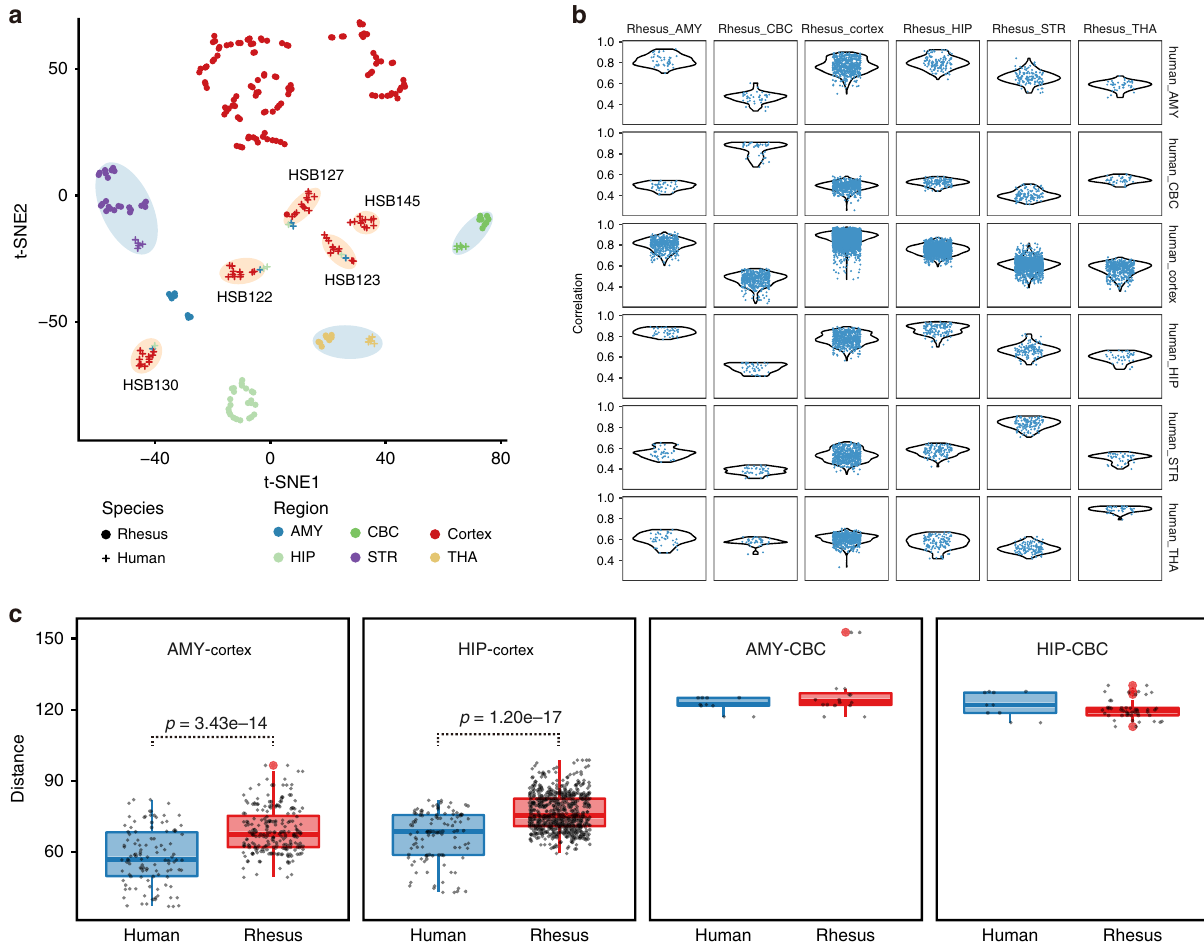
Fig. 2 Similar expression pro fi les between human and macaque brains. a Combined t-SNE using the human and rhesus macaque dataset. The blue shadow circles indicated similar expression pattern in the striatum, thalamus and cerebellar cortex between human and rhesus macaque. The orange shadow circles indicated clusters of samples from the same individual. b Violin plot showing the distribution of correlation coef fi cient of homologous genes in same structure between human and rhesus macaque. c Boxplot showing the euclidean distance between amygdala (AMY) and cortex, hippocampus (HIP) and cortex, AMY and cerebellar cortex (CBC), HIP and CBC in the same species. In boxplots, center line, box edges and whiskers indicate the median, upper and lower quartiles (the 25th and 75th percentiles) and 1.5 × interquartile range,